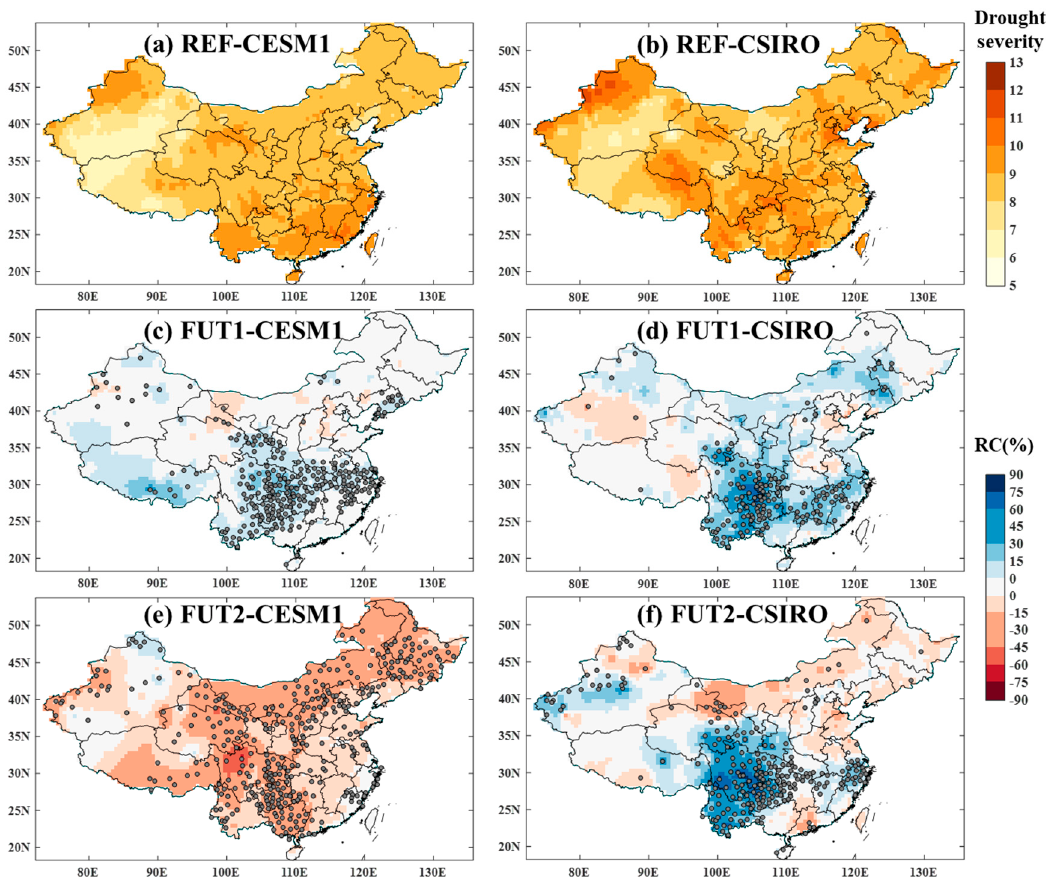
Figure 8. Spatial patterns of drought severity with a 30-year return period in the reference period (REF) and the relative changes (RC) in future periods (FUT1, FUT2) for two climate model ensembles. Stations that present statistically significant changes are marked with filled dots. ( a )The 30-year return period of drought severity in REF for CESM1; ( b ) The 30-year return period of drought severity in REF for CSIRO; ( c ) The RC of the 30-year return period of drought severity in FUT1 for CESM1; ( d ) The RC of the 30-year return period of drought severity in FUT1 for CSIRO; ( e ) The RC of the 30-year return period of drought severity in FUT2 for CESM1; ( f ) The RC of the 30-year return period of drought severity in FUT2 for CSIRO.